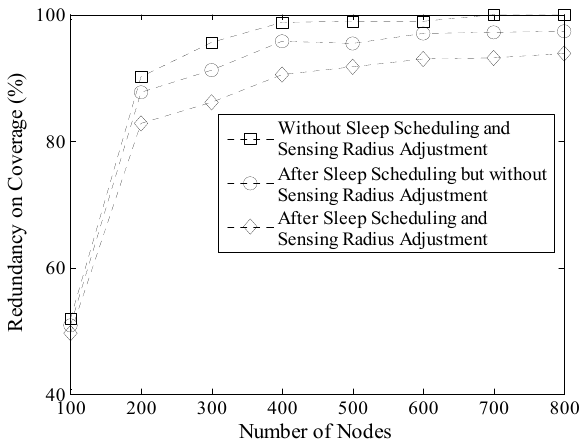
Figure 14. Redundancy on coverage (100 m × 100 m).